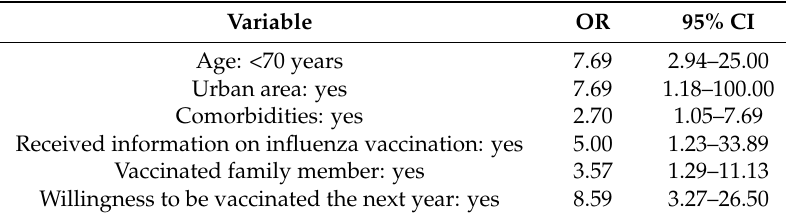
Table 2. Logistic regression model after stepwise selection: association of vaccination against seasonal influenza with selected variables (odds ratio (OR) estimates and 95% confidence intervals (CIs)), n = 230; Pseudo R 2 = 0.327, Area under the Curve (AUC) = 0.802.